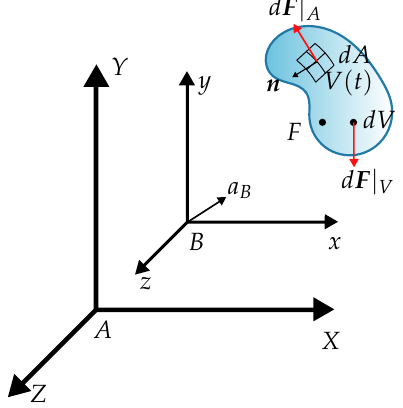
Figure 2. Fluid volume in a non-inertial reference frame